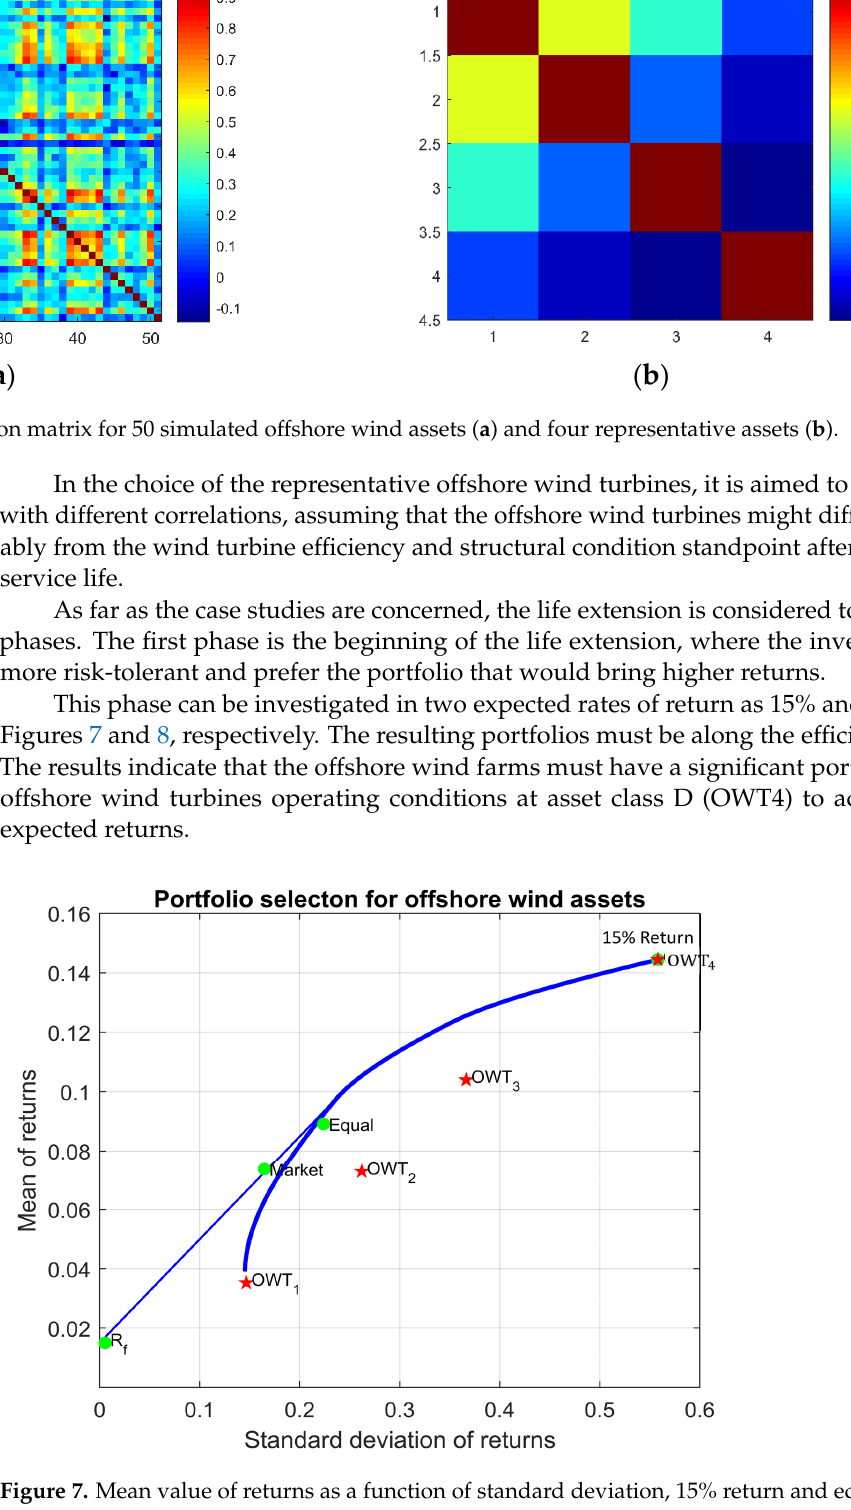
Figure 8. Mean value of returns as a function of standard deviation, 14% return and equal weights. For the second phase, the offshore wind farm is considered to be halfway through the complete life extension. It is reasonable to argue that investors would prefer a less risky operation of the offshore wind farm as the structural conditions are worsening and